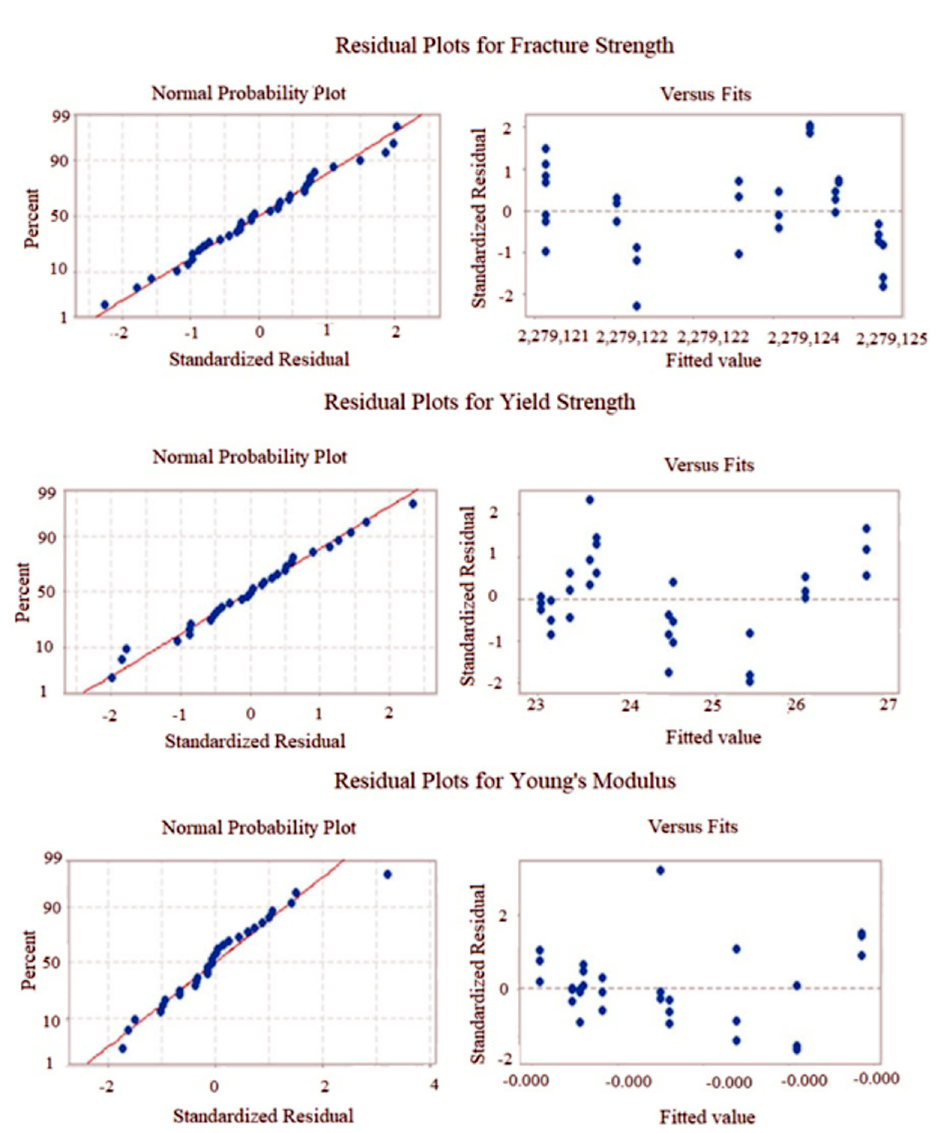
Figure 9. Normality and residual plots obtained from RSM modeled data.